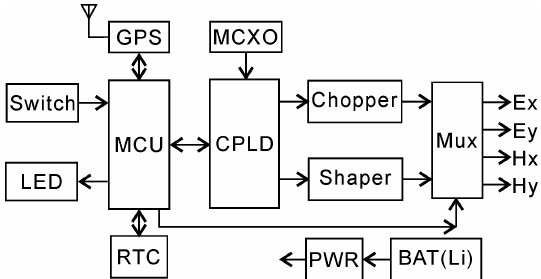
Figure 6. Block diagram of the multifunction waveform generator